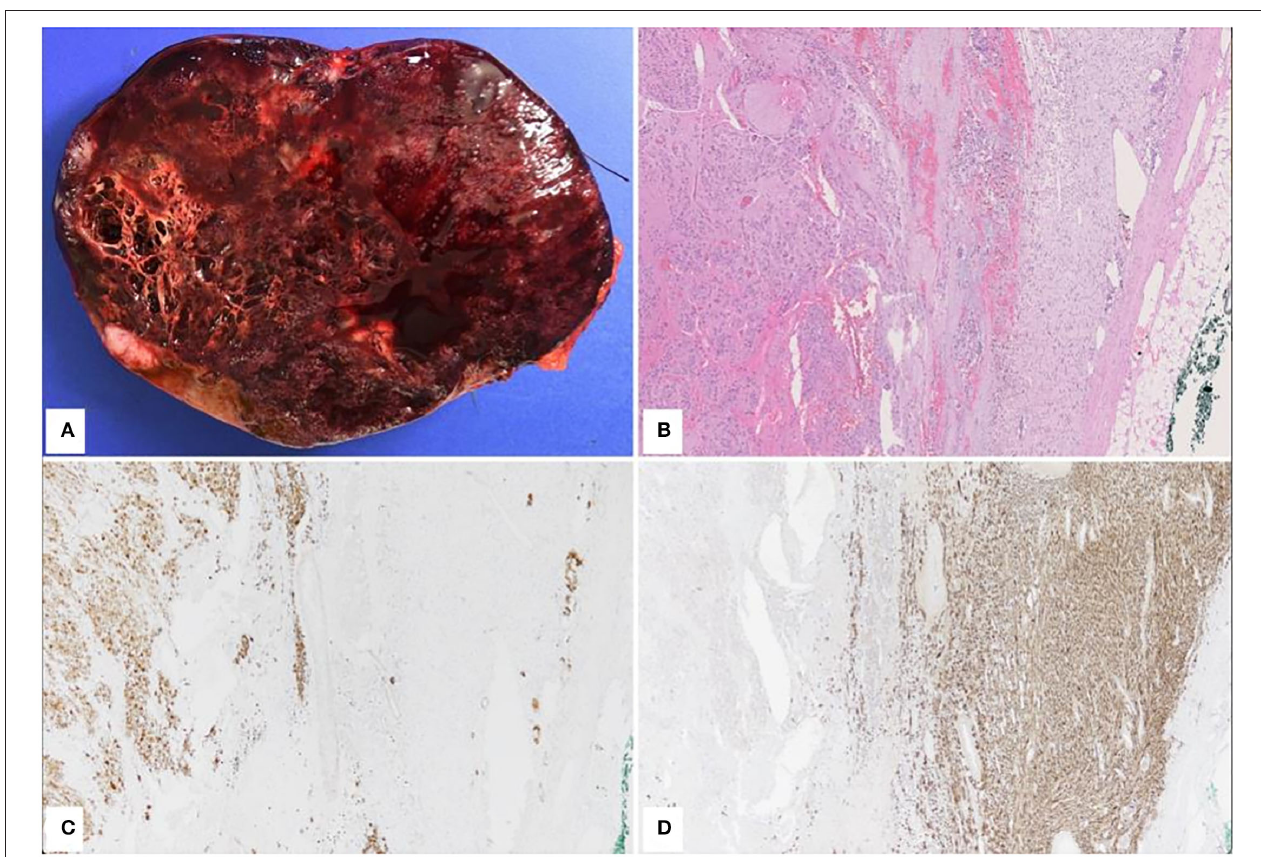
FIGURE 3 | Pathological features. Macroscopically, The cut surface was heterogeneous with solid and microcystic features, hemorrhagic and necrotic areas, and some white nodules. The tumor was well-delimitated showing solid and microcystic features with hemorrhagic and necrotic areas. (A) Histologically, the tumor showed two main components. The central portion of the tumor was composed of ganglion cells at different stage of maturation, embedded in a fibrillary network (B) left portion of the image. The ganglion cells were positive for synaptophysin, chromogranin and MAP2 while they were negative for SF1, inhibin, MYC, CD99, cytokeratin, GFAP, and ATRX. SDHB was expressed. (C) The second component of the tumor was located at the periphery and included spindle Schwann cells positive for S100 (D) .